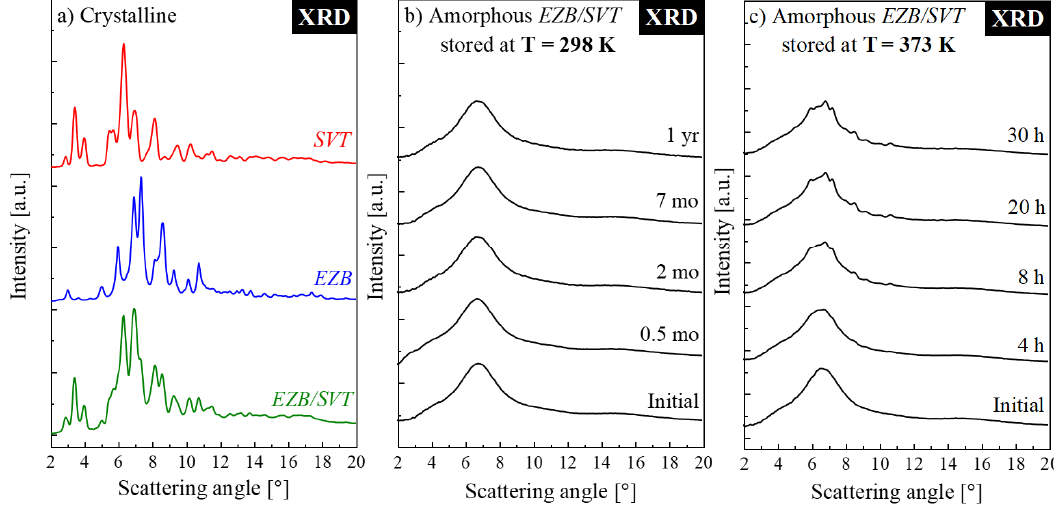
Figure 3. XRD patterns of ( a ) crystalline systems stored at 298 K ( red line—pure SVT; blue line—pure EZB; green line—EZB/SVT physical mixture), ( b ) amorphous EZB/SVT system stored at 298 K, ( c ) amorphous EZB/SVT system stored at 373 K.